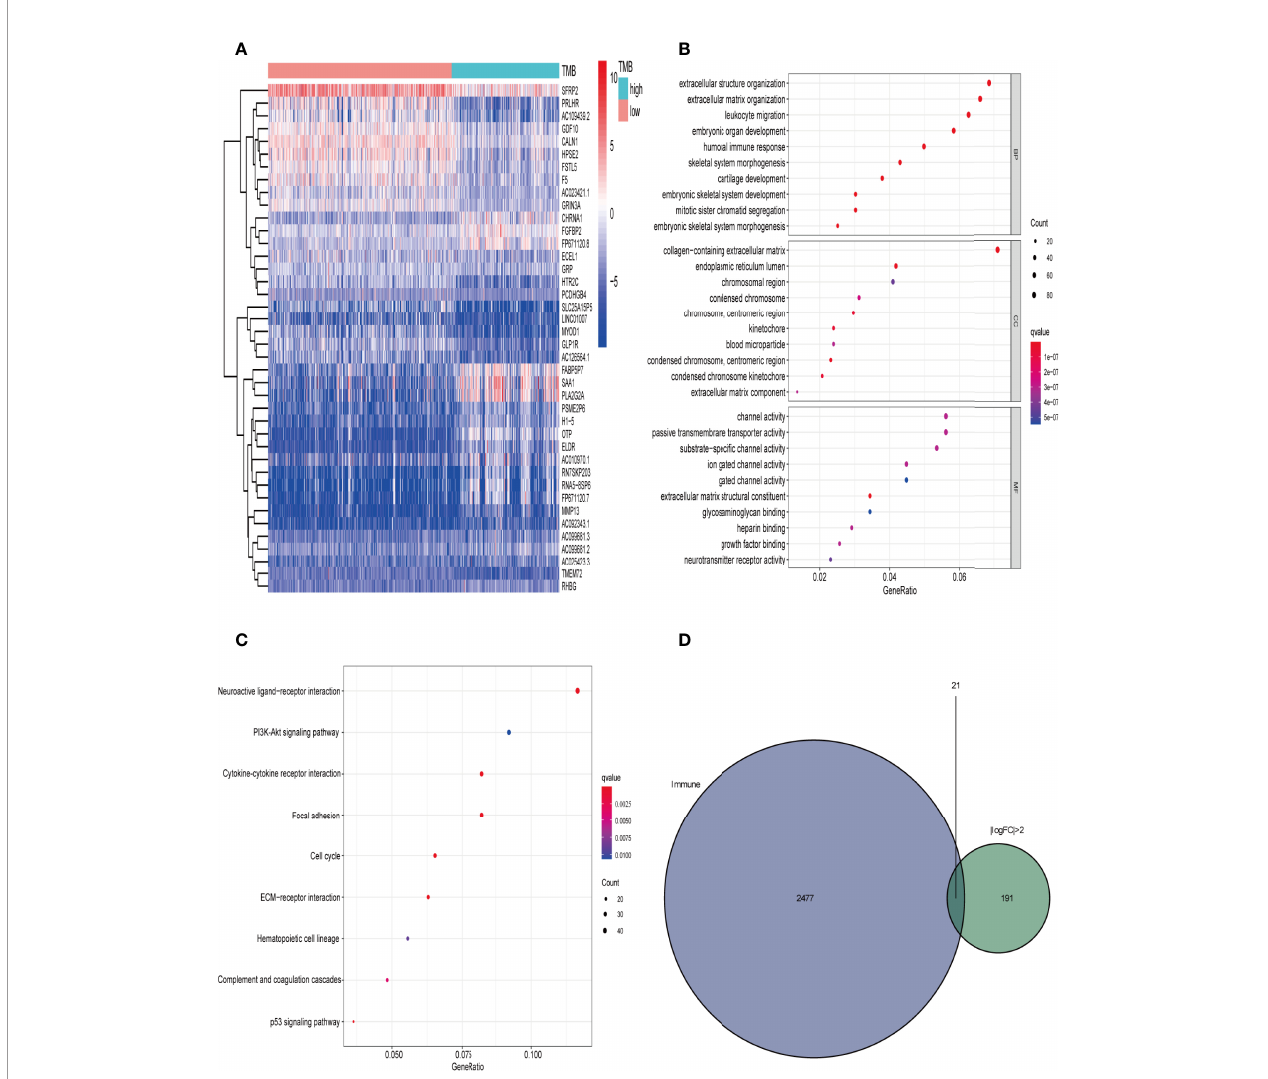
FIGURE 3 | Comparison of gene expression pro fi les in low- and high-TMB samples. (A) Top 40 differentially expressed genes (DEGs) are shown in a heatmap plot (red: low-TMB, cyan: high-TMB); (B, C) GO (biological process [BP], cellular component [CC], and molecular function [MF]) and KEGG pathway enrichment results, respectively, revealed that these genes are involved in immune-related pathways (top 10); (D) identi fi cation of tumor mutation burden (TMB)-related